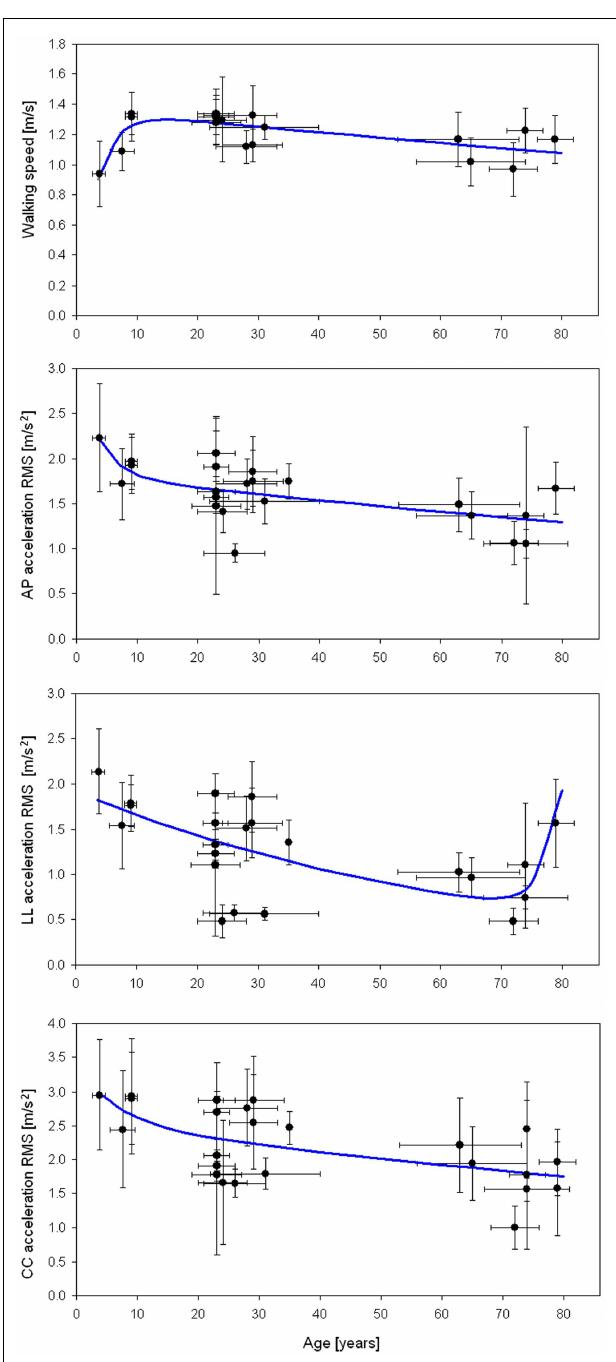
FIGURE 2 |Walking speed and acceleration RMSs . Mean ( ± SD) of walking speed, AP, LL, and CC acceleration RMSs with respect to mean ( ± SD) age for the studies in Table 1 . Regression lines (in blue) were obtained with a bi-exponential fit.